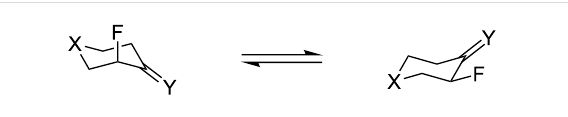
Figure 1: 2-Fluorocyclohexanone (X = CH 2 and Y = O) derivatives (X and Y = CH 2 , NH, O or